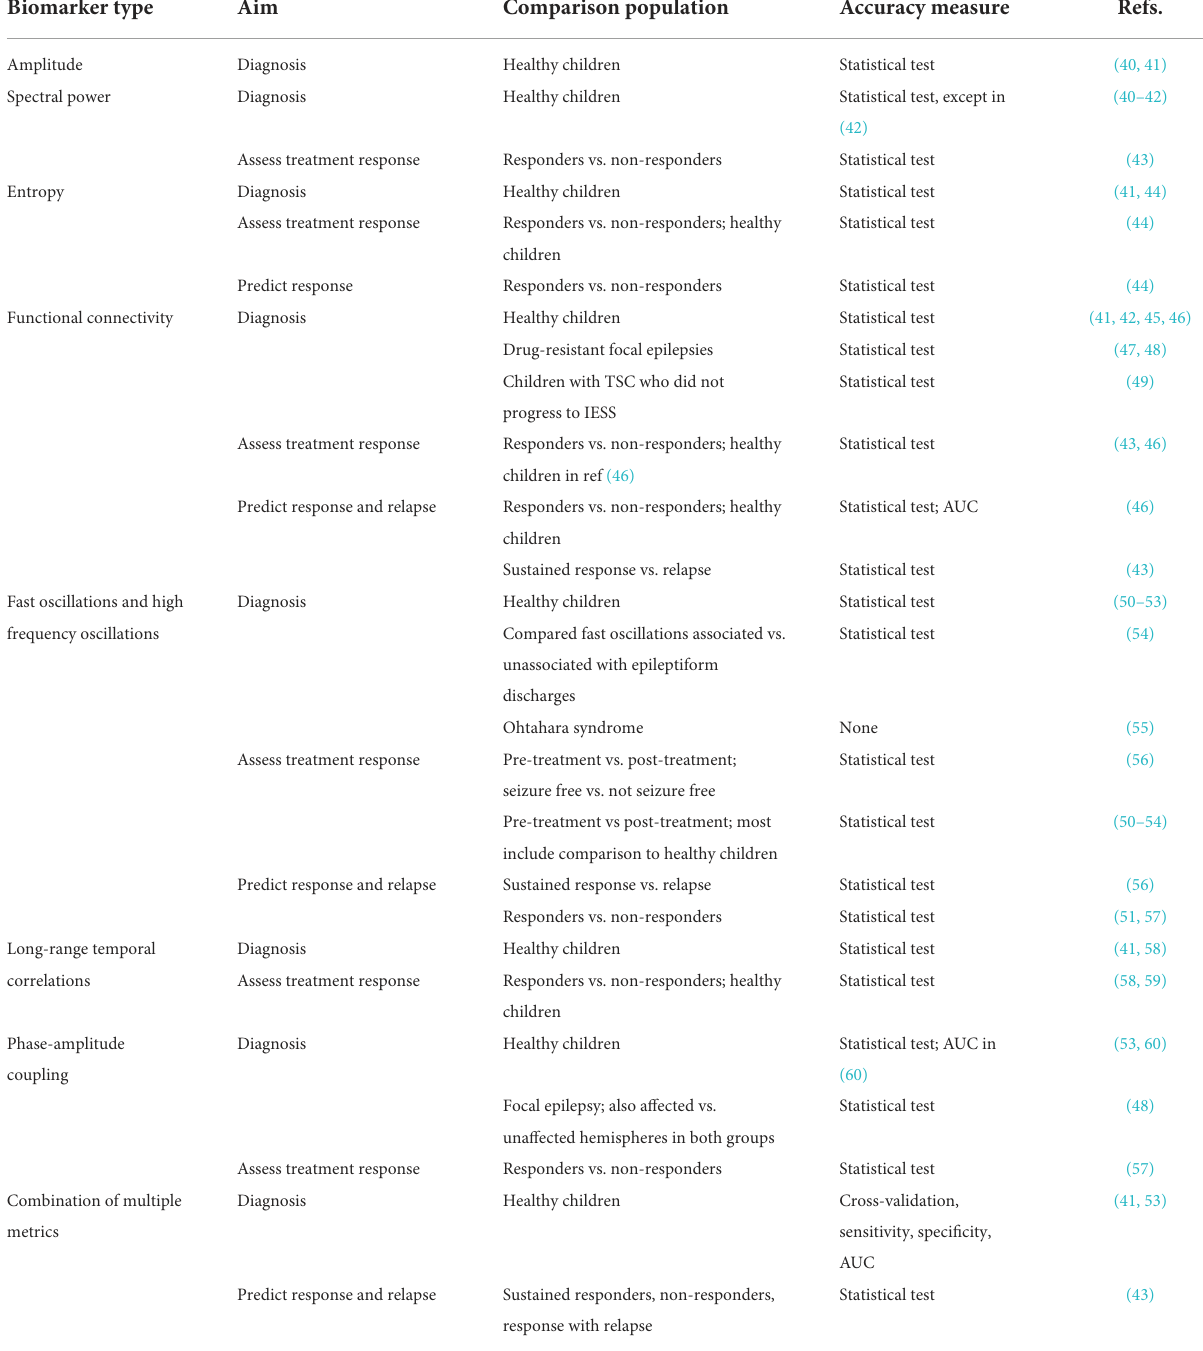
TABLE 3 Summary of all studies of computational EEG biomarkers related to